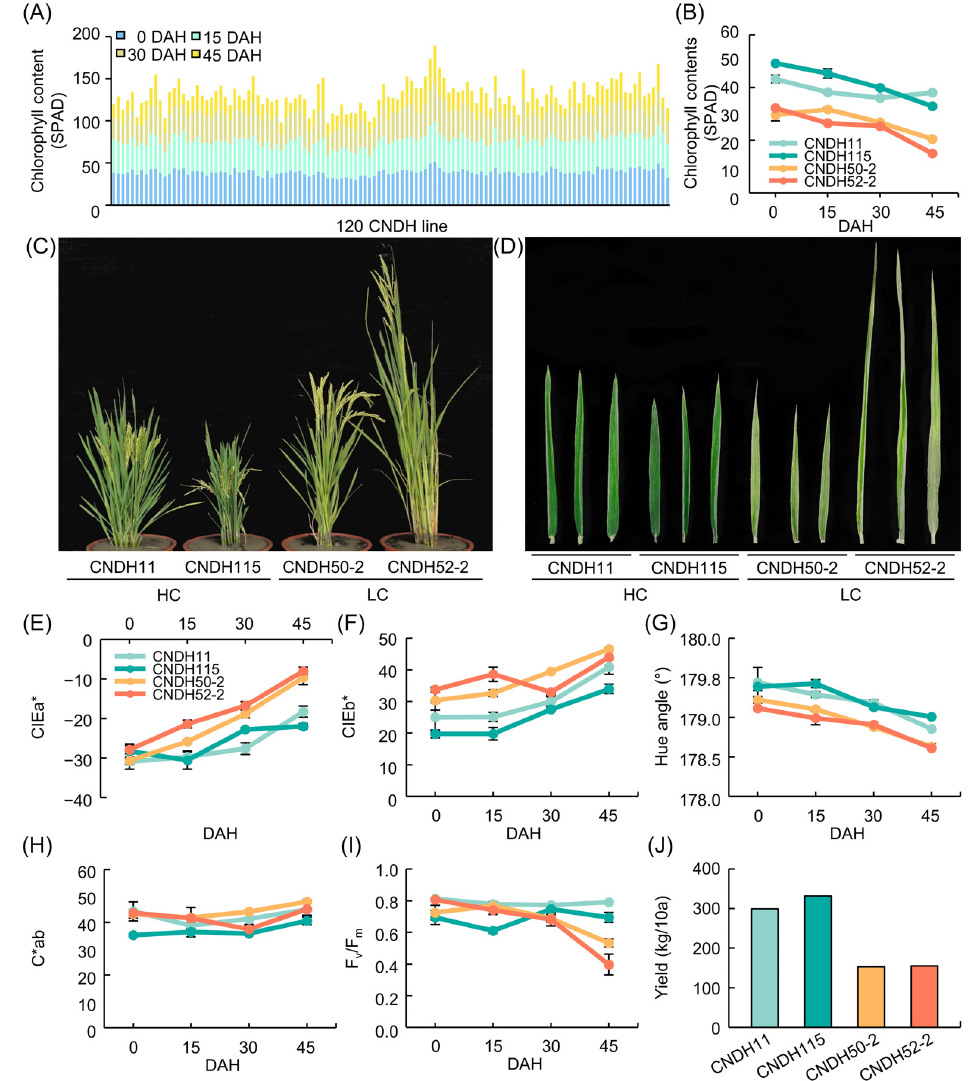
Figure 5. Chlorophyll related trait in CNDH line. ( A ) Changes in chlorophyll content (SPAD) in 120 CNDH line. CNDH11 and CNDH115 had the high chlorophyll content. CNDH50-2 and CNDH 52-2 had the low chlorophyll content. ( B ) Chlorophyll content. ( C ) Phenotypes images. ( D ) Flag leaf images. ( E ) CIEa* value. ( F ) CIEb* value. ( G ) Hue angle. ( H ) C*ab. ( I ) F v /F m . ( J ) Yield.